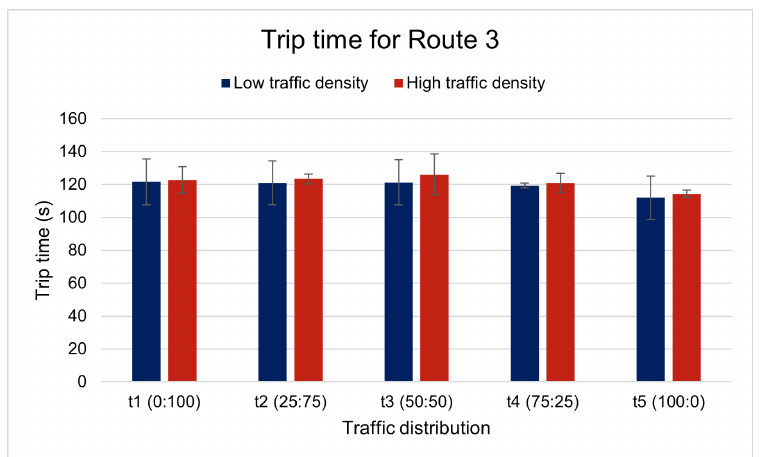
Figure 11. Average trip time for Route 3 in low and high traffic densities.